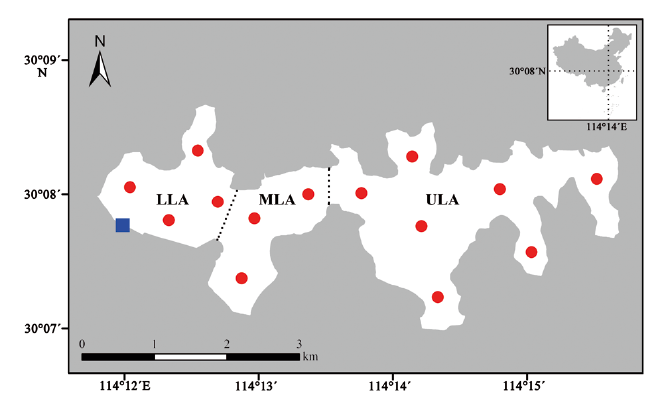
Fig. 1. Lake Shangshe, China. Red circles, blue square, and dotted lines represent sampling sites, sluice, and nets, re- spectively. LLA: lower lake area; MLA: middle lake area; ULA: upper lake